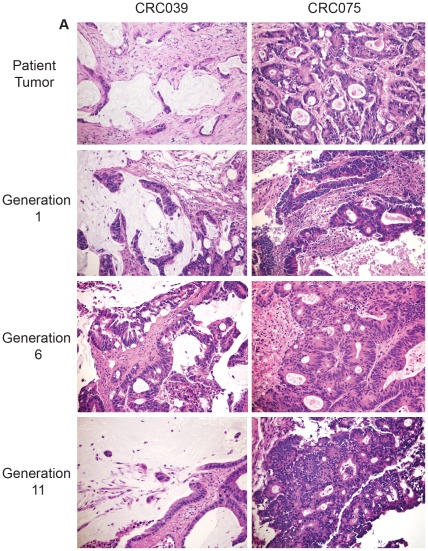
PDCCE tumor pathology is retained after 11 generations in mice.H&E stained sections of two independent well-differentiated adenocarcinomas (CRC039 and CRC075) show that tumor architecture remains similar after 11 passages in NOD/SCID mice. Images shown are at 20× magnification.